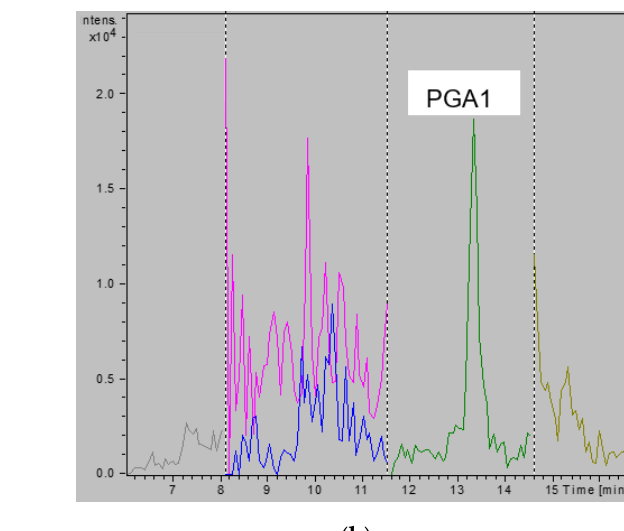
Figure 1. Dummy template imprinting scheme to produce MIPs complementary to prostaglandins. The initial template molecule (arachidonic acid) is represented in black, while the analyte to be bound (PGE2) in the samples is represented in blue.